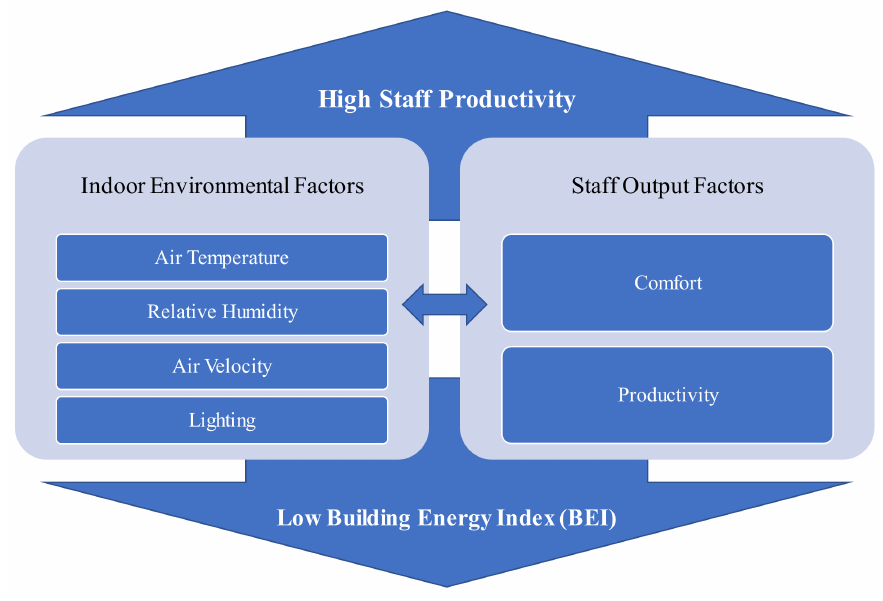
Figure 1. Theoretical